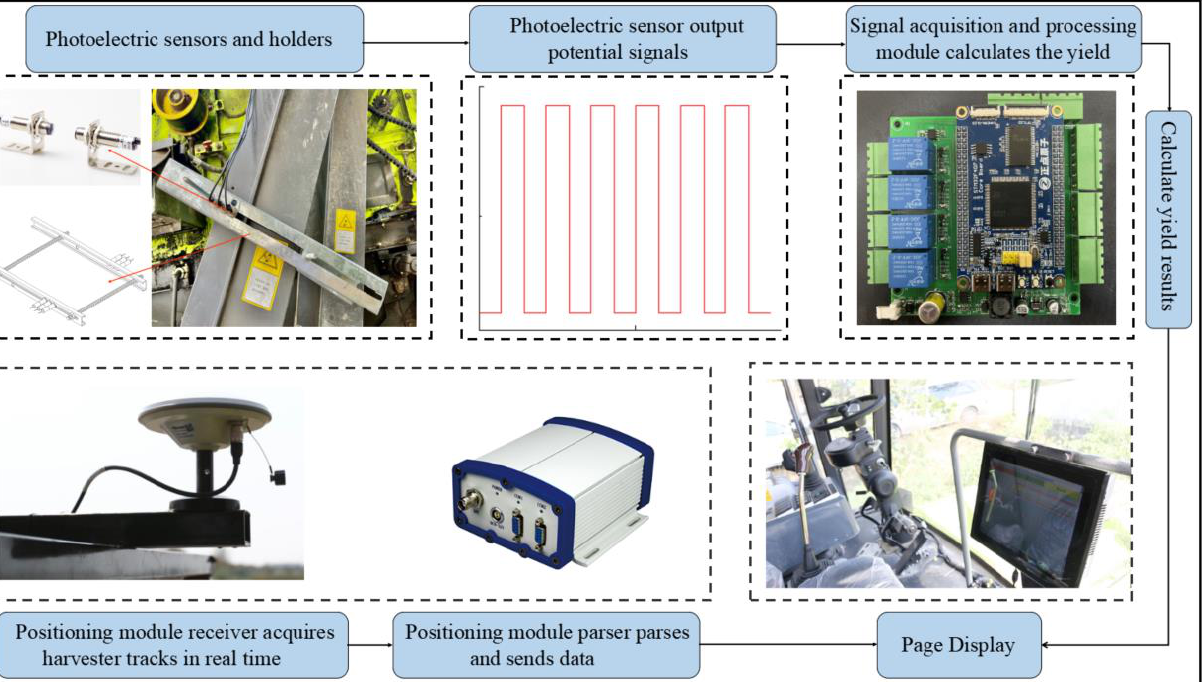
4 of 15 Figure 1. Grain yield monitoring principle: ( a ) overall structure diagram of yield monitoring system; ( b ) photoelectric sensors mounting position; ( c ) changes in sensor potentials.